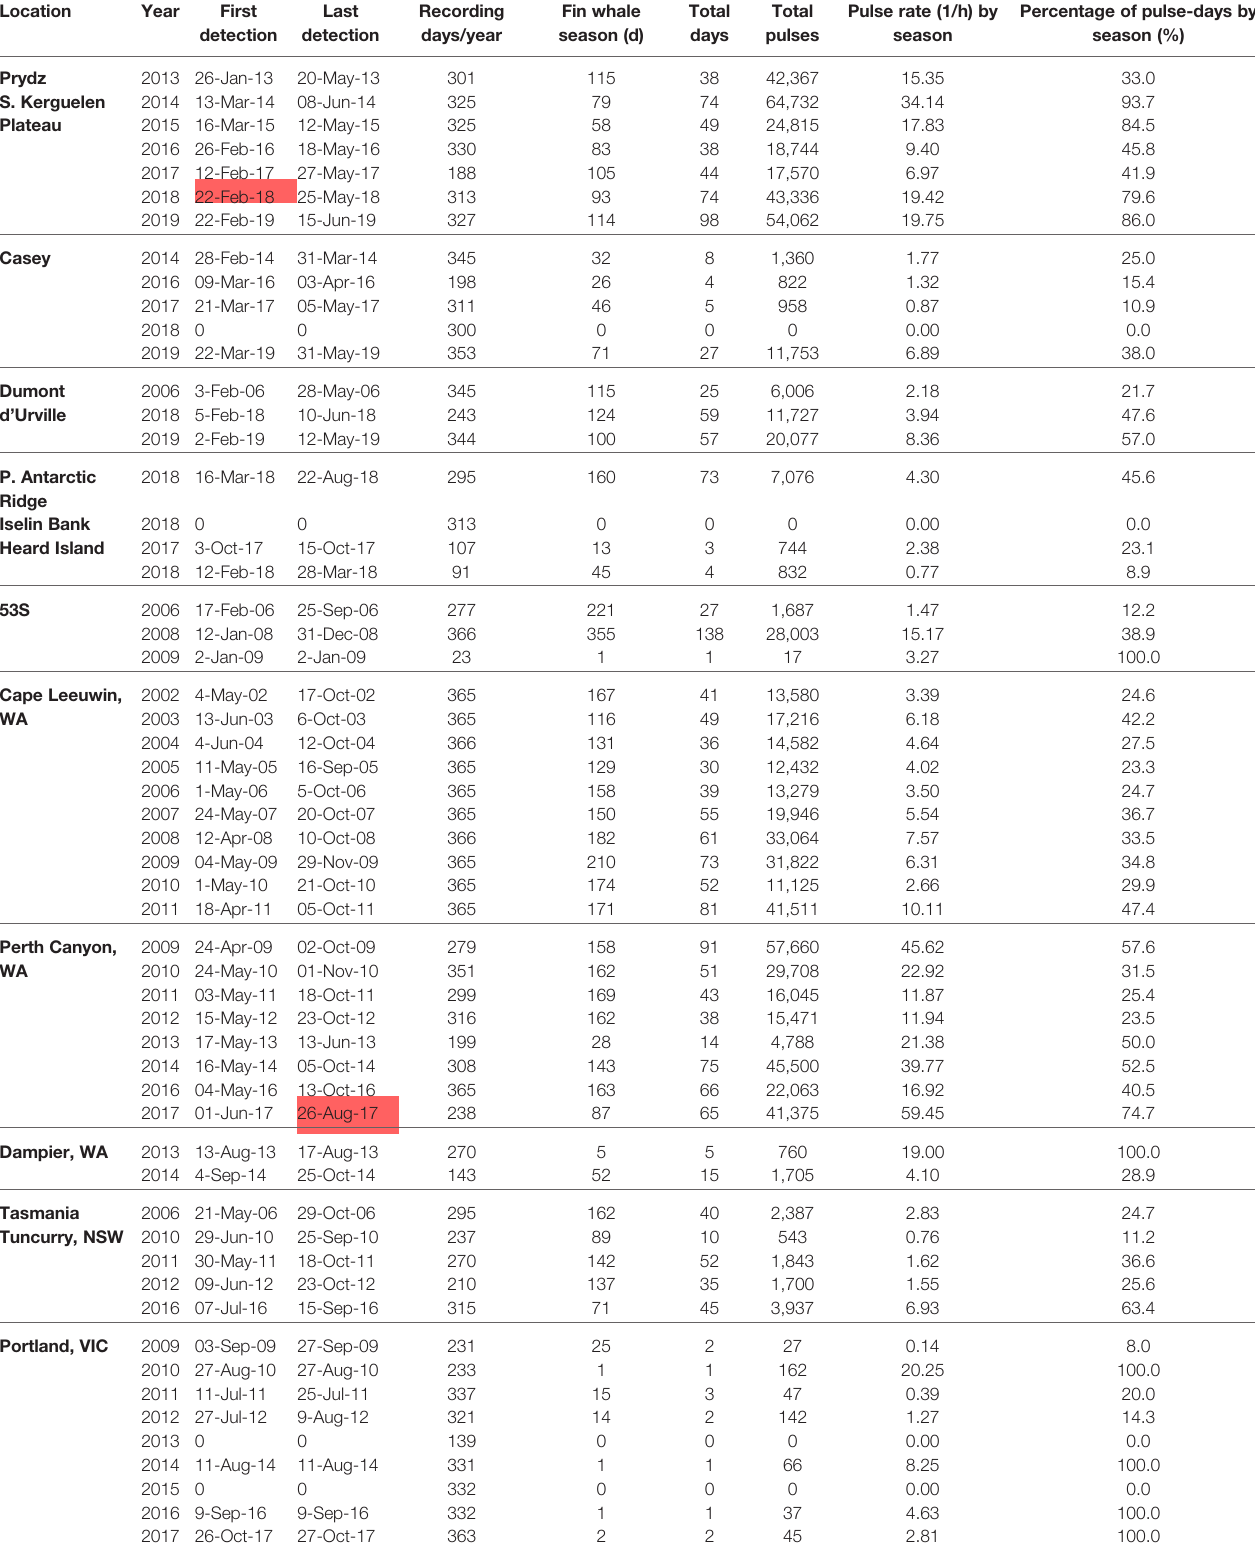
TABLE 2 | Fin whale detection data for all recording